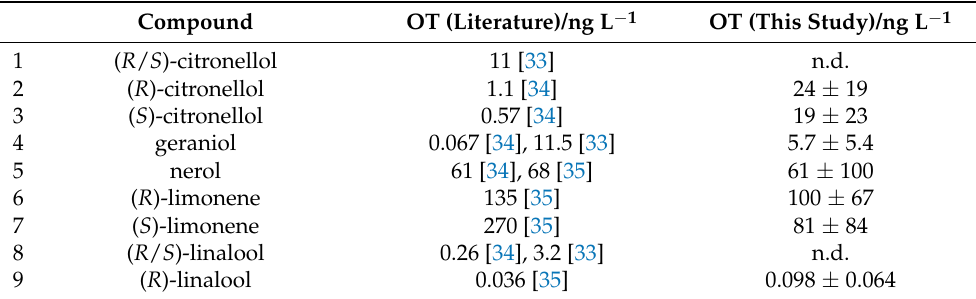
Table 3. Comparison of odor thresholds in the air (OT) reported in the literature and determined in this